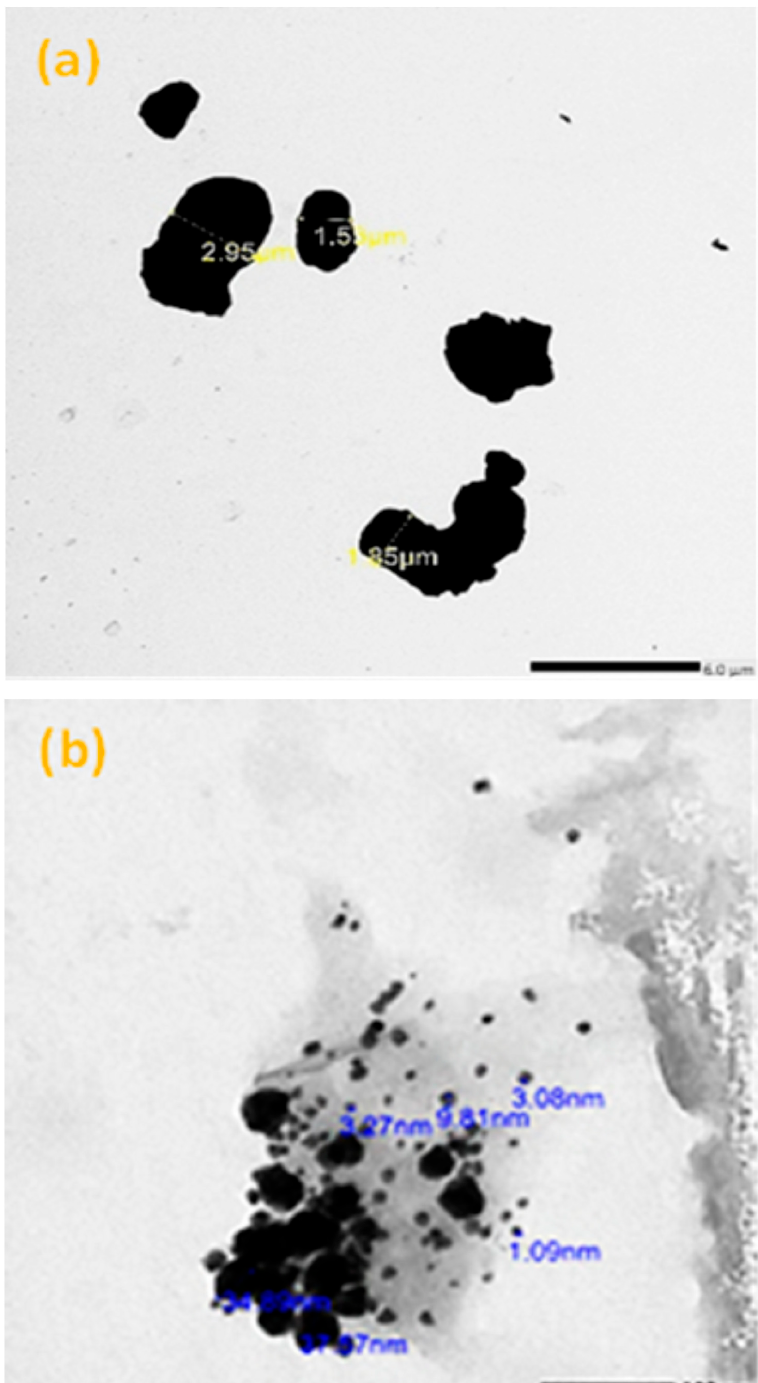
Figure 1. The TEM image of ( a ) micro-Bi 2 O 3 particles, ( b ) nano-Bi 2 O 3 particles.